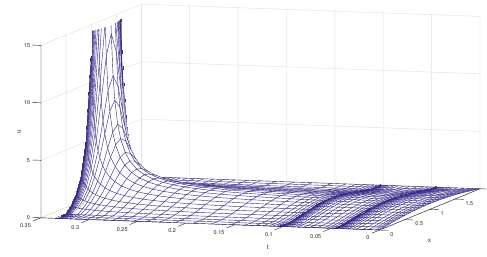
Fig. 2: Evolution of the maximal solution of Eq. (1)